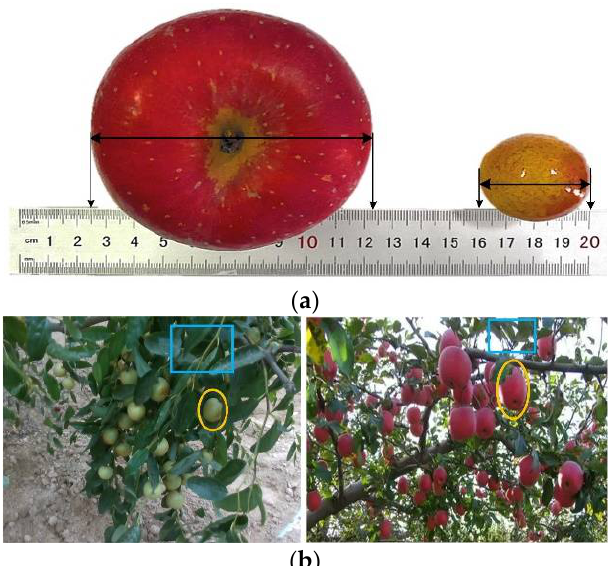
Figure 1. Challenges faced by winter jujube detection compared with apples. Yellow and blue boxes represent fruits and background, respectively. ( a ) Smaller fruit size. ( b ) Lower contrast and higher density.